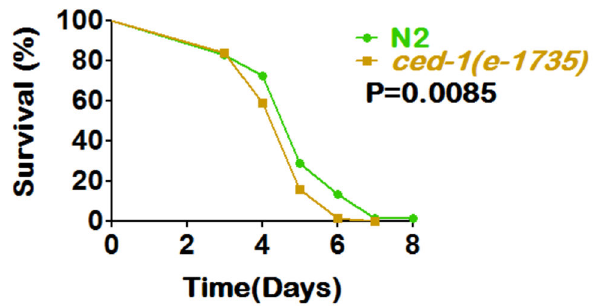
Figure 4. Ced-1 mutant C. elegans worms are more sensitive to killing by DT104. Ced-1 loss-of-function mutant worms [ ced-1 (e1735)] die significantly faster (P=0.0085) than wild type N2 worms, when exposed to Salmonella Typhimurium DT104. L4 stage wild type N2 (--●--) and ced-1 (e1735) (--■--) worms were exposed to DT104 and assayed daily for survival.